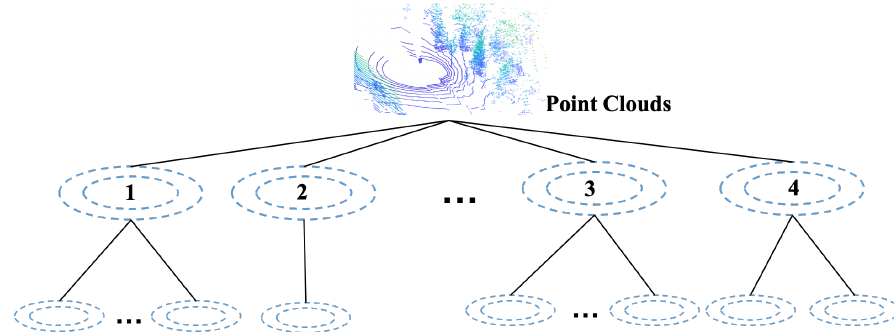
Figure 2. The proposed hierarchical model. The root of the tree is the input point cloud. Each level is an independent Gaussian Mixture Model (GMM). The ellipse denotes weighted Gaussians. Gaussian 1: the parent Gaussian spawns another mixture of size C in the normal generation. Gaussian 2: the local point clouds are defined as being well modeled by their distribution shape. Gaussian 3: the children mixtures are determined as being well modeled by the information metric. Gaussian 4: the size of GMM children is cut in half if ill-conditioned covariance is